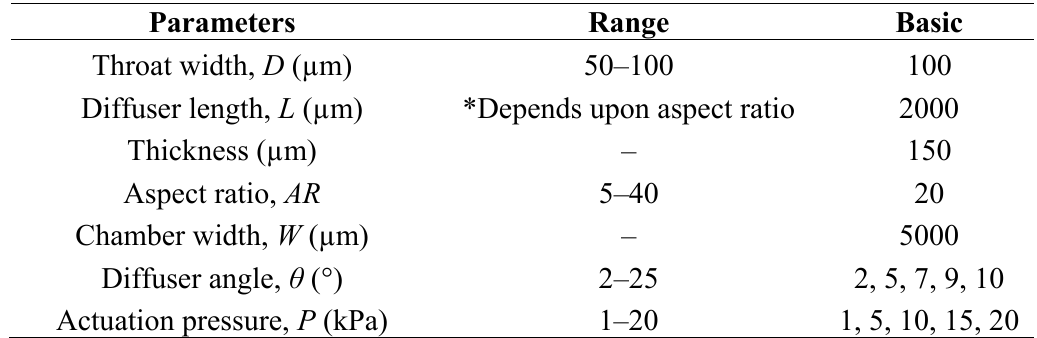
Table 2. Range of parameters simulated in